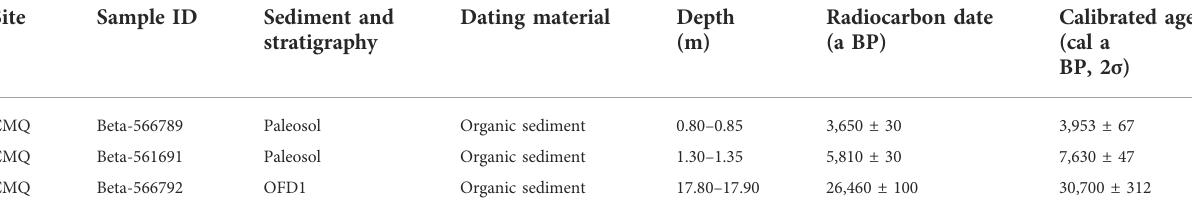
TABLE 3 Calibrated radiocarbon dates of the CMQ and ZHK pro fi le in the Yellow River source area on the northeast Tibetan